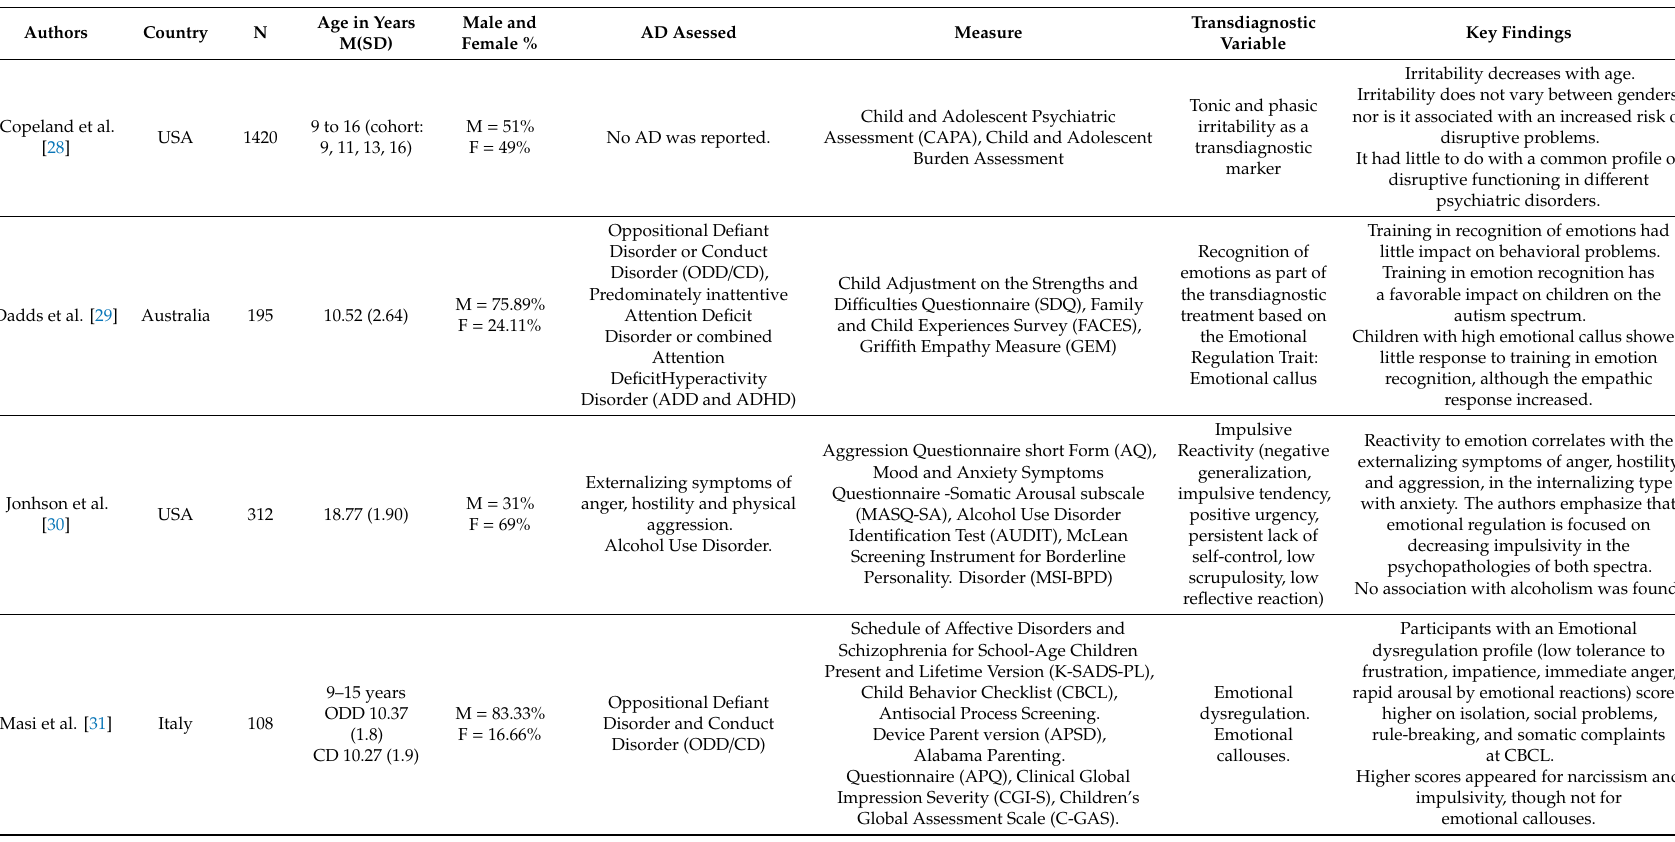
Table 3. Reviewed empirical studies including transdiagnostic variables in antisocial disorders at an emotional